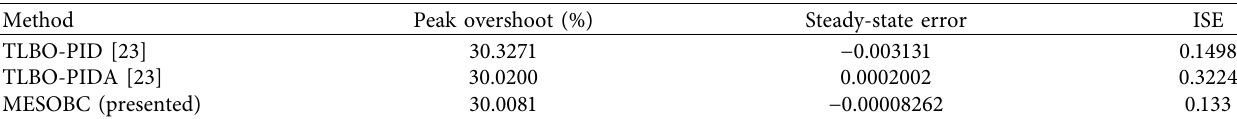
K g and g ) and ± 30% load voltage variation. g and ± 30% load voltage